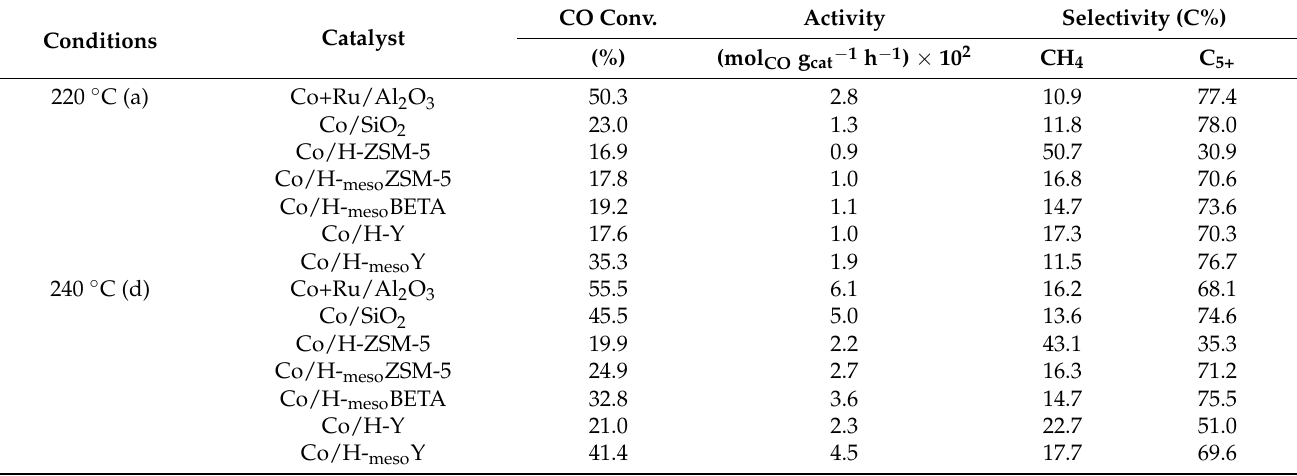
Table 3. FTS performance of the Co catalysts under 2 reaction conditions.